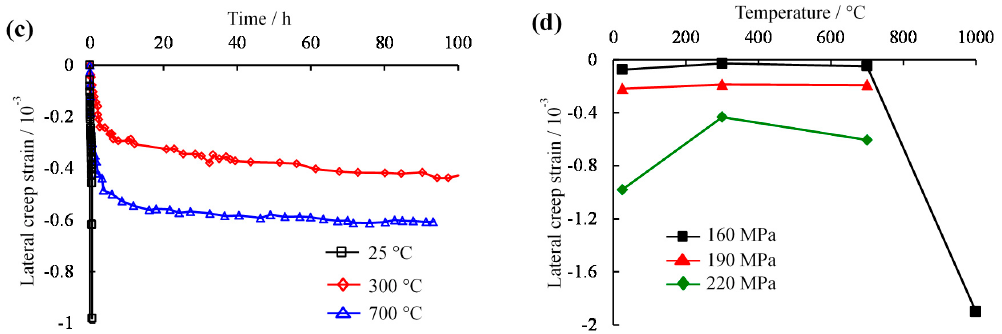
Figure 6. Lateral creep strain ‐ time curves under same stress condition at different temperatures ( σ 3 = 25 MPa): ( a ) σ 1 − σ 3 = 160 MPa; ( b ) σ 1 − σ 3 = 190 MPa; ( c ) σ 1 − σ 3 = 220 MPa; ( d ) Relationship between lateral creep and temperature.